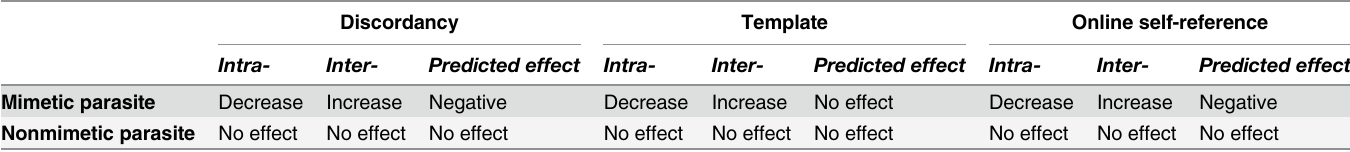
Table 3. Summary of predictions for egg color variation and responses to experimental increase in intraclutch color variation based on different cognitive mechanisms underlying egg recognition, as a result of coevolution per se with mimetic versus nonmimetic brood parasites.